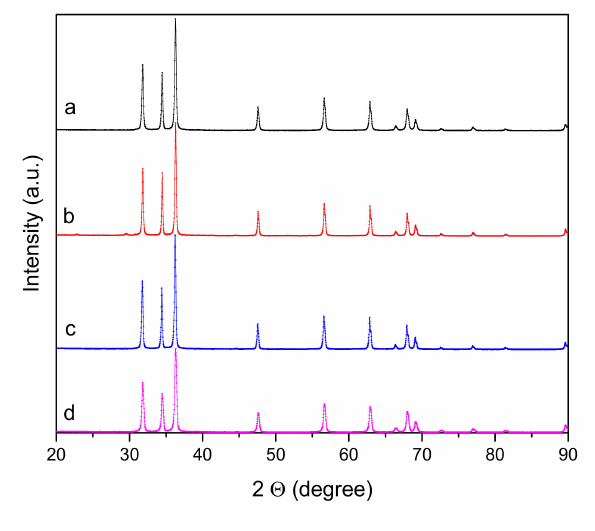
Figure 3. X-ray diffraction patterns of Zn-Ca nanocomposites. ( a ) ZnO, ( b ) Zn-Ca 1, ( c ) Zn-Ca 3, ( d ) Zn-Ca 5.